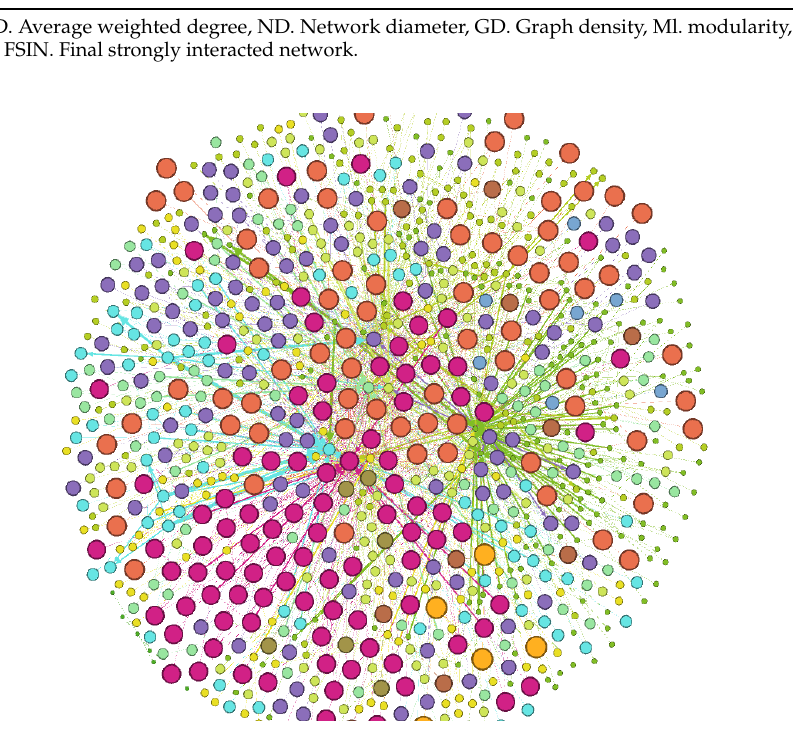
Figure 2. Final strongly drug-drug interaction network. Nodes and edges in each network represent compounds and interactions between them, respectively. Darker color and larger size nodes show the strength of drug IDs/ZINC IDs. As shown in Table 2, network 1 comprises of 507.0 nodes and 1169 edges with modularity of 0.518; the second network consists of 266 nodes and 564 edges with 0.524 modularity. Network 3 showed 185.0 nodes and 383.0 edges with 0.538 modularity. Network 4 comprises 64.00 nodes and 98.00 edges with 0.613 modularity. Network 5 contains 923.0 nodes and 2146 edges with a modularity of 0.509. Network 6 consists of 188 nodes and 395.0 edges with a modularity of 0.571. Network 7 comprises 469.0 nodes and 1067 edges and possesses a modularity of 0.525. Network 8 consists of 107.0 nodes and 181.0 edges, and 0.001 graph density with a modularity of 0.552. Network 9 comprises 369.0 nodes and 870.0 edges with modularity of 0.500. Network 10 consists of 541.0 nodes and 1166 edges with a 0.501 modularity. Network 11 comprises 218.0 nodes and 331.0 edges and 0.528 modularity, while network 12 contains 300.0 nodes, 666.0 edges, and 0.500 modularity. Likewise, the finally generated strong network contains 923.0 nodes and 2166 edges with 0.503 modularity (Table 2). Table 2. Statistical parameters used to predict network interactions of various natural and synthetic compounds. Networks